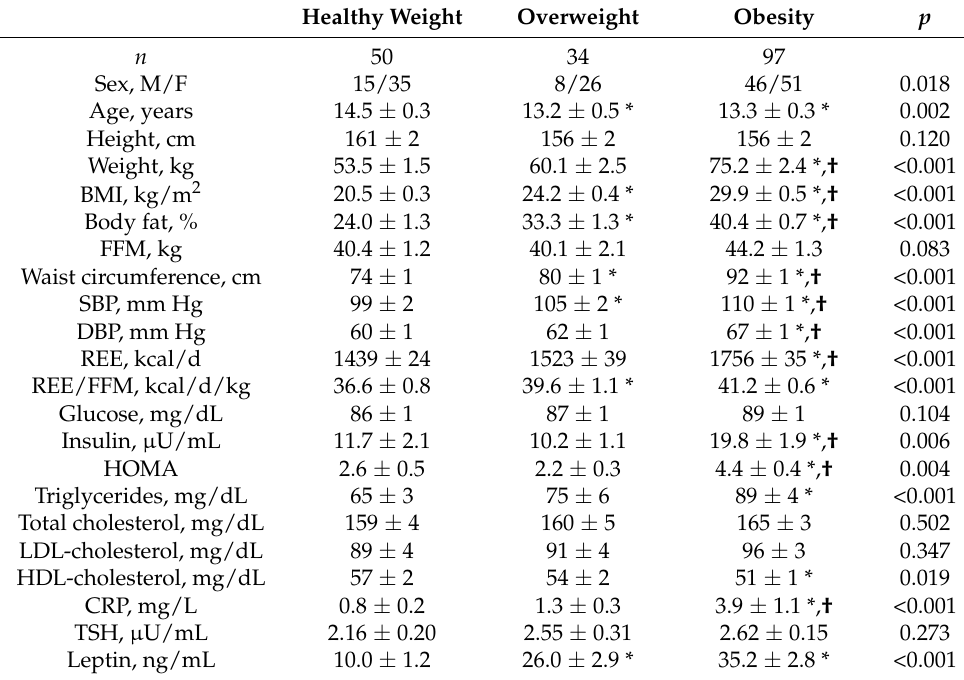
Table 1. Demographic, biochemical and metabolic characteristics of the children and adolescents classified according to ponderal